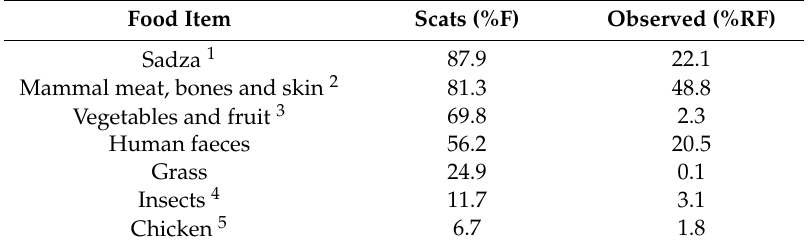
Table 1. Frequency of occurrence (%F) of the principle food items in 945 dog scats, compared to the relative mass of items from 689 observed meals, presented as relative frequency of occurrence